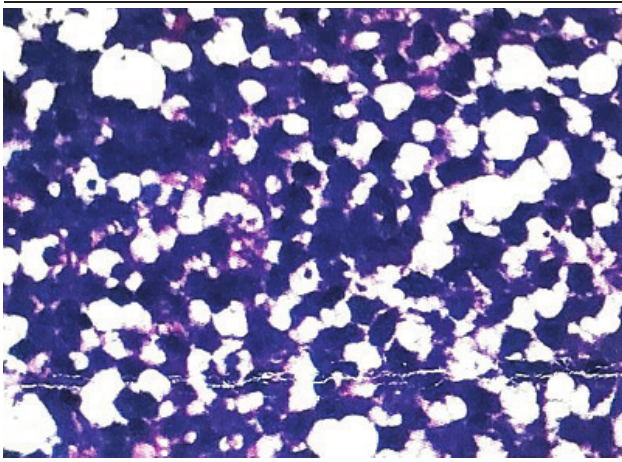
fIgure 6 – Photomicrograph (HE stain; 200× magnification) of the anatomopathological examination, demonstrating histiocytic proliferation of large cells, with wide cytoplasm and presence of some cells with reniform nuclei and mixed B-cell and T-cell infiltrate of small lymphocytes, without atypias and co-expression of CD68, S100 protein and CD1. The constellation of findings is compatible with Langerhans histiocytosis HE: hematoxylin and